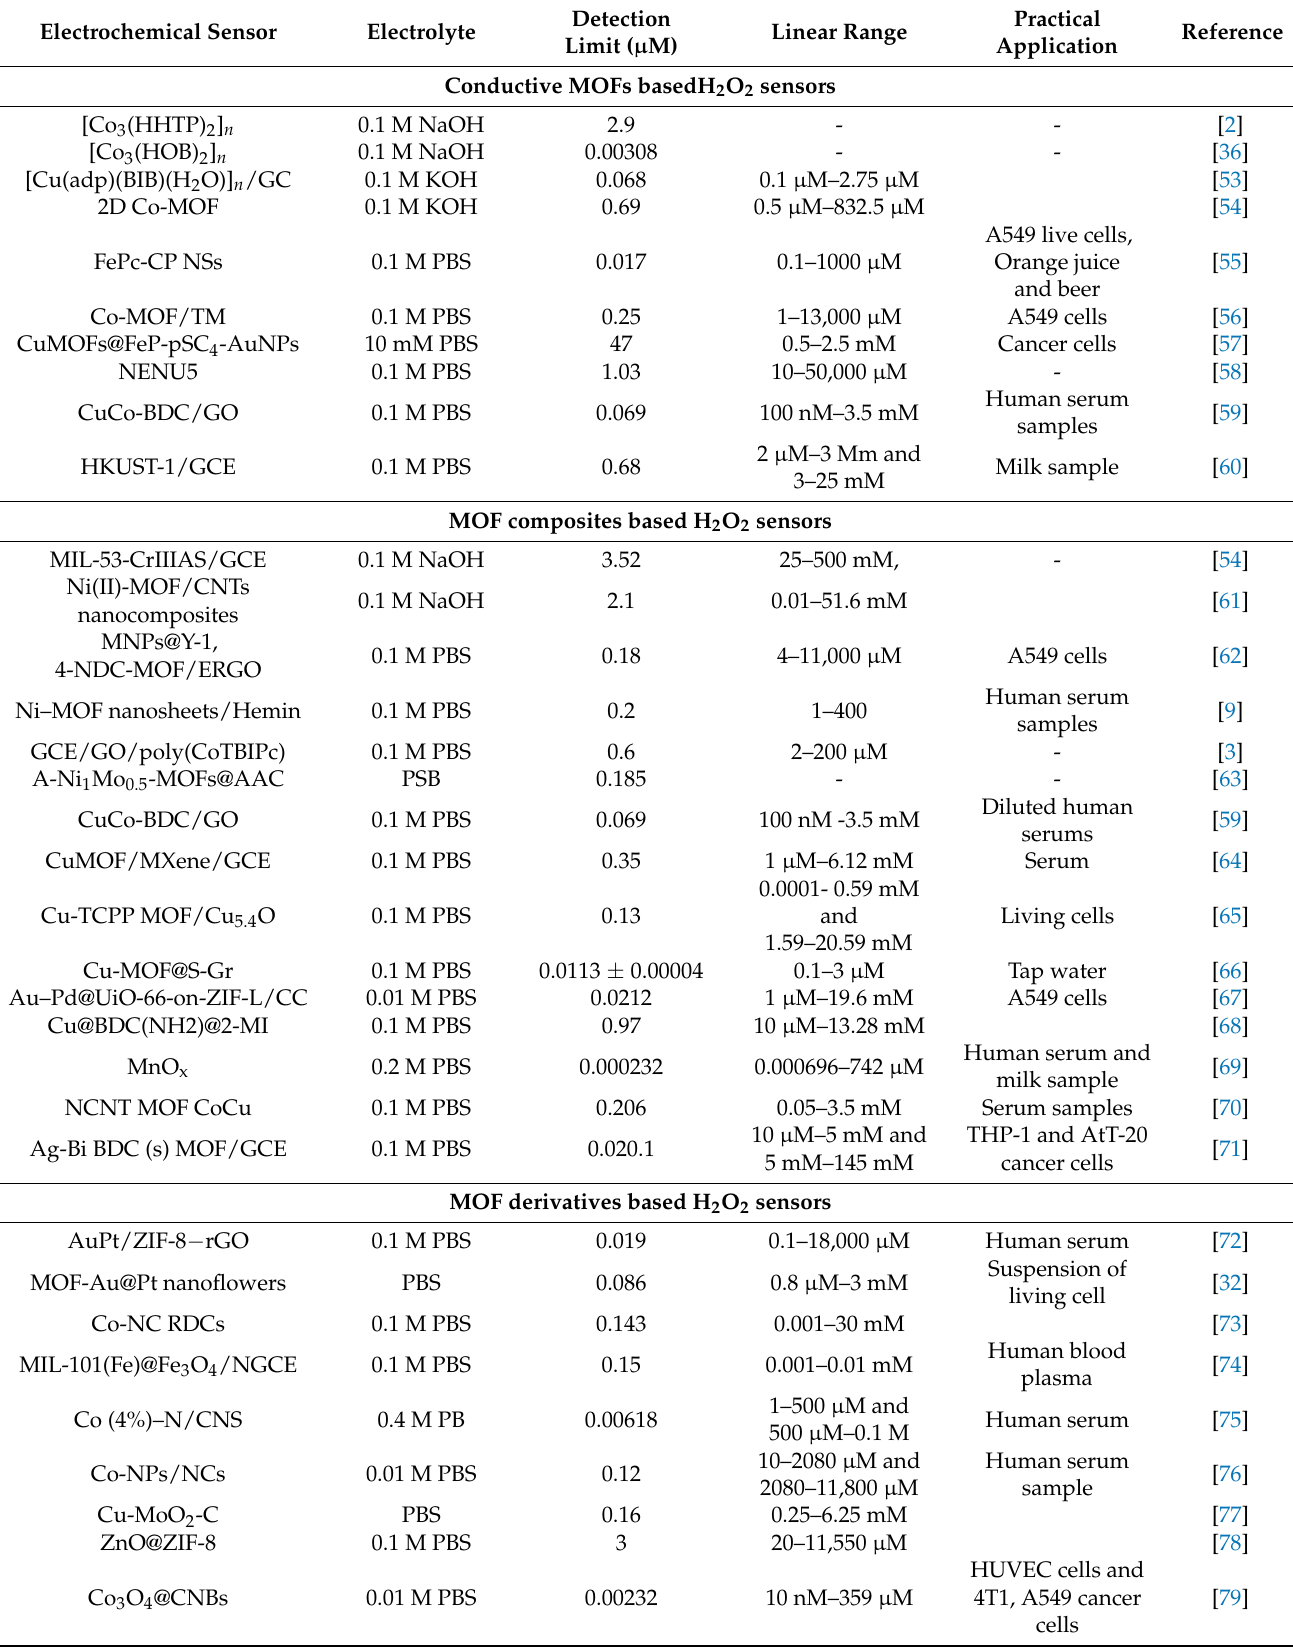
Table 1. Recently reports of H 2 O 2 electrochemical